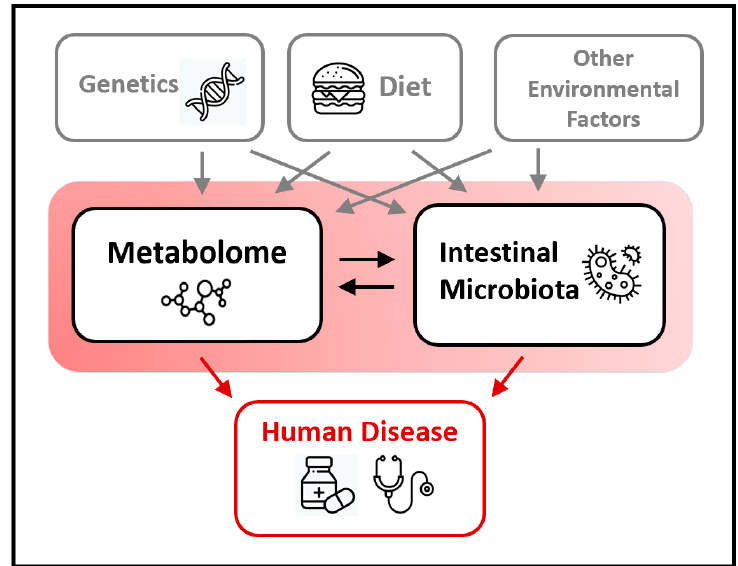
Figure 1. This simplified schematic illustrates two-way interactions between the metabolome and gut microbiome. Both the metabolome and microbiome are influenced by genetics, nutritional, and other environmental factors. Both also impact risk of human disease.